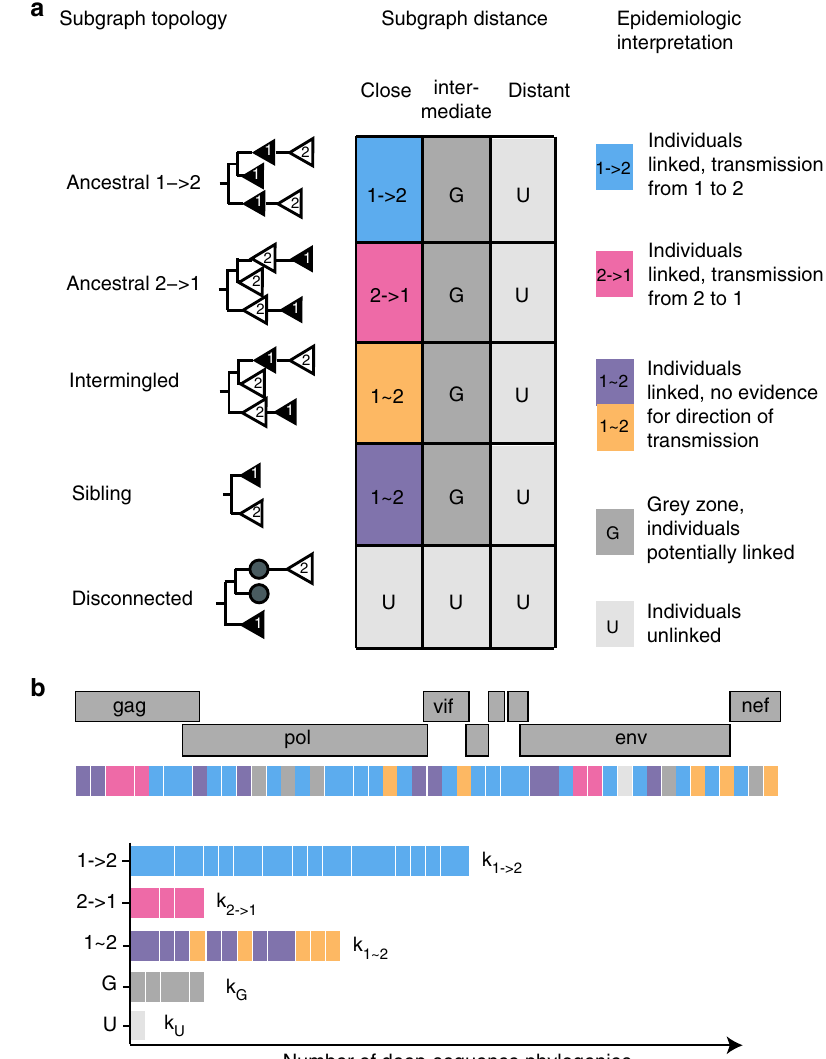
Fig. 4 Epidemiological interpretation of deep-sequence phylogenetic data. a The 5 × 3 contingency table describes how deep-sequence phylogenetic patterns between two individuals were epidemiologically interpreted. Viral phylogenetic patterns between two individuals were summarized in terms of subgraph distance and subgraph topologies. There are fi ve possible subgraph topologies between two individuals. All subgraphs of person 1 can be disconnected from the subgraphs of person 2 by another individual. If subgraphs of two individuals are adjacent, i.e. not disconnected by another individual, they can be consistently ancestral to each other in the same direction, intermingled in that some subgraphs are ancestral in one direction and others in the opposite direction, or siblings. The subgraph distance between viral subgraphs was strati fi ed into ‘ close ’ (<0.025 substitutions per site), ‘ intermediate ’ (0.025 – 0.05 substitutions per site), and ‘ distant ’ (>0.05 substitutions per site) based on the couples ’ analysis shown in Fig. 3a. Epidemiologic interpretations are indicated in colours. When only one sequence per individual is available, subgraphs of individuals correspond to the tips in a phylogeny, are either disconnected or siblings, and thus the direction of transmission is not inferable. b To determine the statistical support in inferences on transmission and the direction of transmission, analyses were repeated across the genome and the observed relationship types 1 → 2, 2 → 1, 1 ~ 2, G, U were counted (respectively denoted by k 1 → 2 , k 2 → 1 , k 1~2 , k G , k U ). To avoid overcon fi dence, an adjustment was made to account for the fact that overlapping windows are not statistically independent (see Supplementary Note 1). Evidence for no transmission between individuals 1 and 2 was estimated by ^ μ ¼ k = n ; evidence for transmission between 1 and 2 was estimated by ^ λ ¼ ð k þ k þ k Þ = n ; and evidence for transmission from 1 to 2 given that 12 1 ! 2 1 (cid:3) 2 2 ! 1 12 U transmission occurred between 1 and 2 was estimated by ^ δ 12 ¼ k 1 ! 2 = ð k 1 ! 2 þ k 2 ! 1 Þ ; see Methods for further while their partner was already immuno-compromised with a Amongst all pairs, the false discovery rate was 16.3% CD4 cell count below 400 cells per mm 3 blood. The phylogen- [8.8 – 28.3%]. Error rates varied slightly depending on the exact etically inferred source was consistent with clinical evidence in con fi guration of parameters in the phyloscanner analyses, though 19/35 pairs, inconsistent in 5/35 pairs, and could not be inferred not substantially (Supplementary Tables 5 – 6). Similar error rates reliably in 11/35 pairs. In two of the fi ve inconsistent cases, CD4 were observed in phylogenetic analysis of 454 deep-sequence data data were only weakly indicative of the direction of transmission, over a 320 bp region of the env gene among 33 couples and it is possible that we overestimated error rates for these pairs with known direction of transmission and con fi rmed linked with CD4 data to 20.8% [9.2 – 40.5%] (Supplementary Note 4). infection in the HPTN 052 trial 37 . Our fi ndings are based on